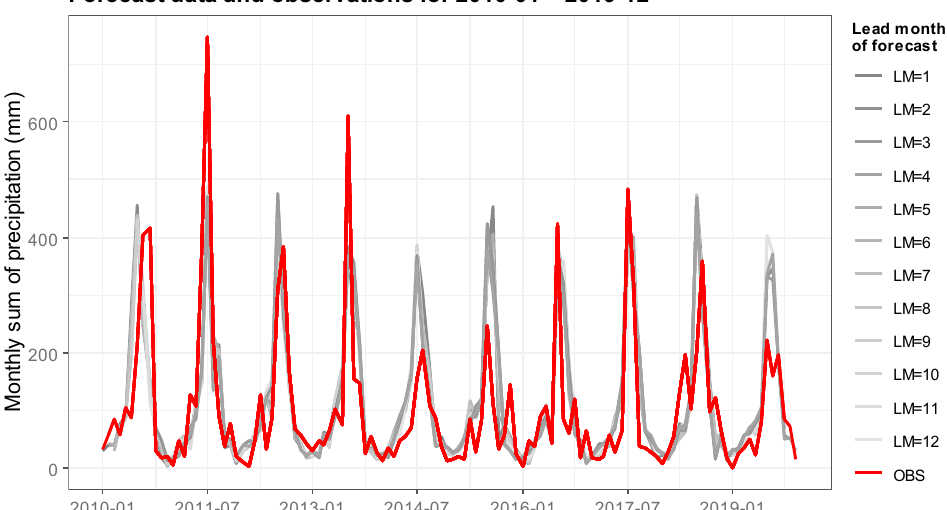
Figure 13. Results of monthly precipitation forecasting according to the lead month of forecast.